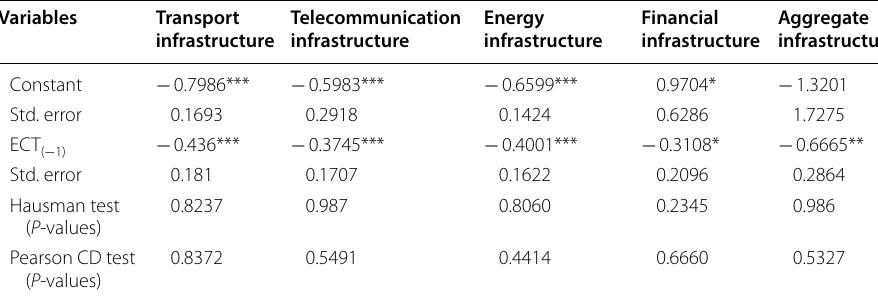
PMG in all columns. The Pearson CD test presents that there is no problem of cross-sectional dependency